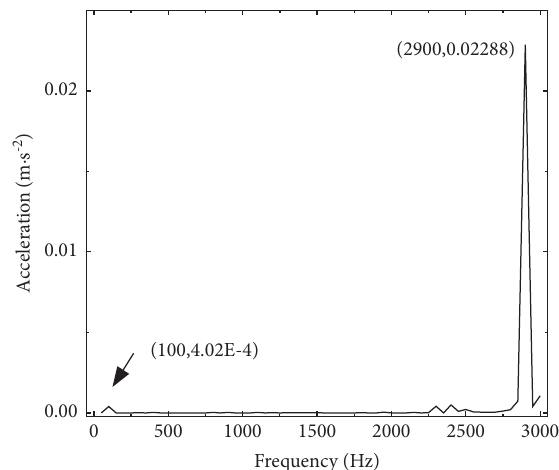
Figure 10: Radial vibration response of the busbar shell in COMSOL.